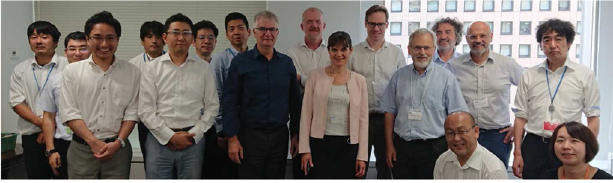
Fig. 5. Most of the whole team members during the fi nal report wrap-up in Tokyo JAEA of